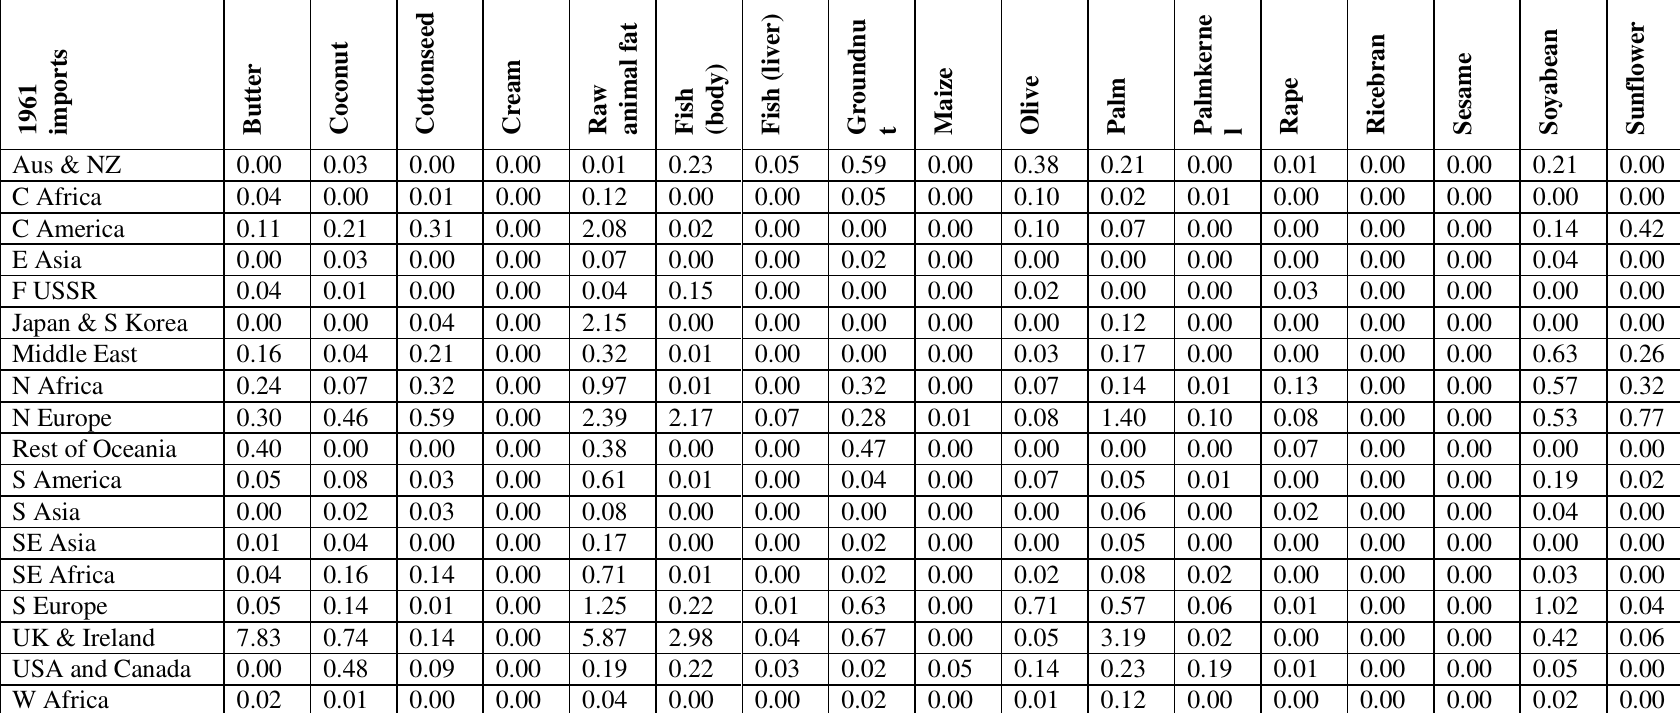
Table 3: World lipid imports, Kg/capita/year, 1961 (Source: FAOSTAT data, 2006).